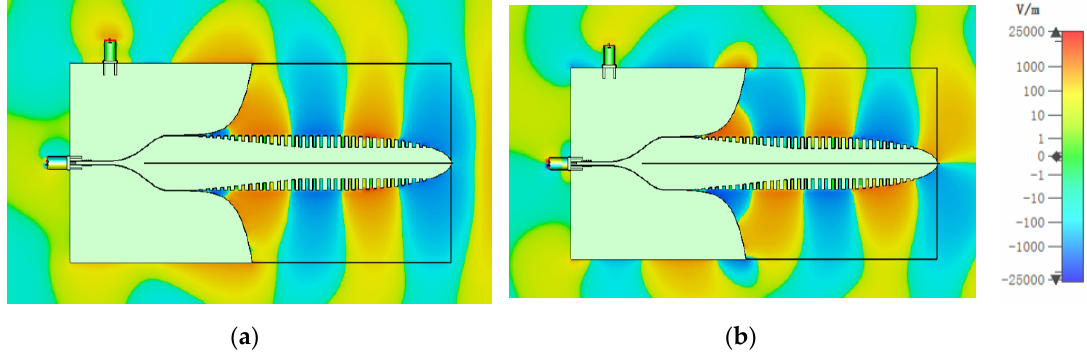
Figure 5. Magnitude of transverse field distribution of the sum beam and difference beam at 6.45 GHz on the top layer of the antenna. ( a ) Sum beam; ( b ) difference beam.